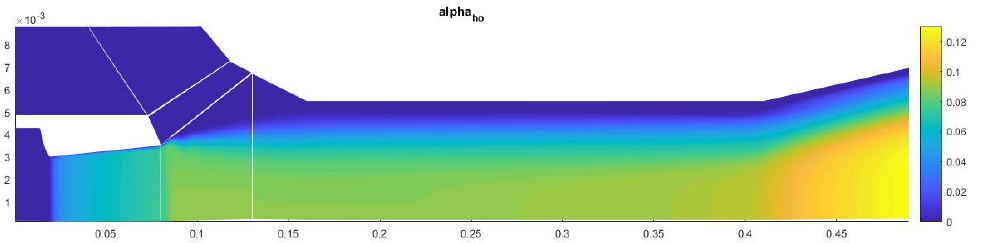
Figure 13. Contours of the field of the mass fraction of water formed in homogeneous condensation.